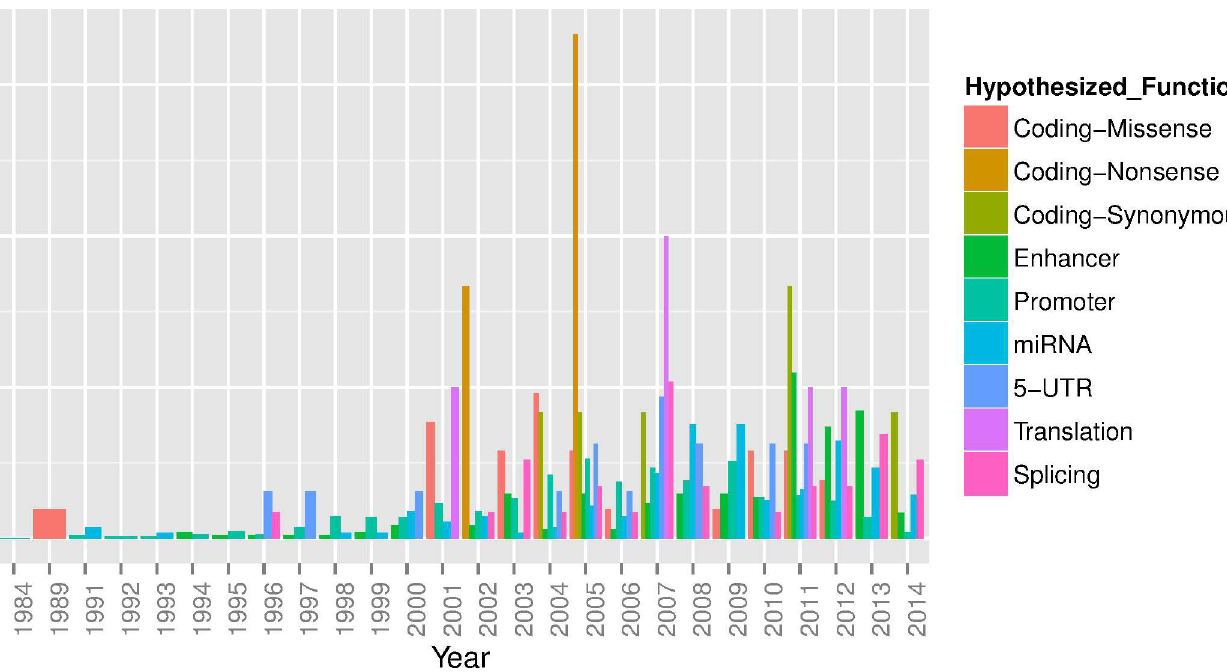
Fig 3. The functional hypothesis tested (‘Hypothesized Function”) by year for 2,610 variants reported in a functional allelic assayfound through literature review.